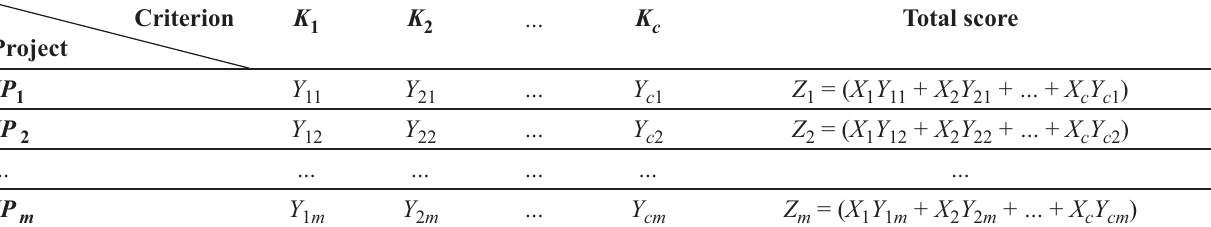
Table 4. Project evaluation